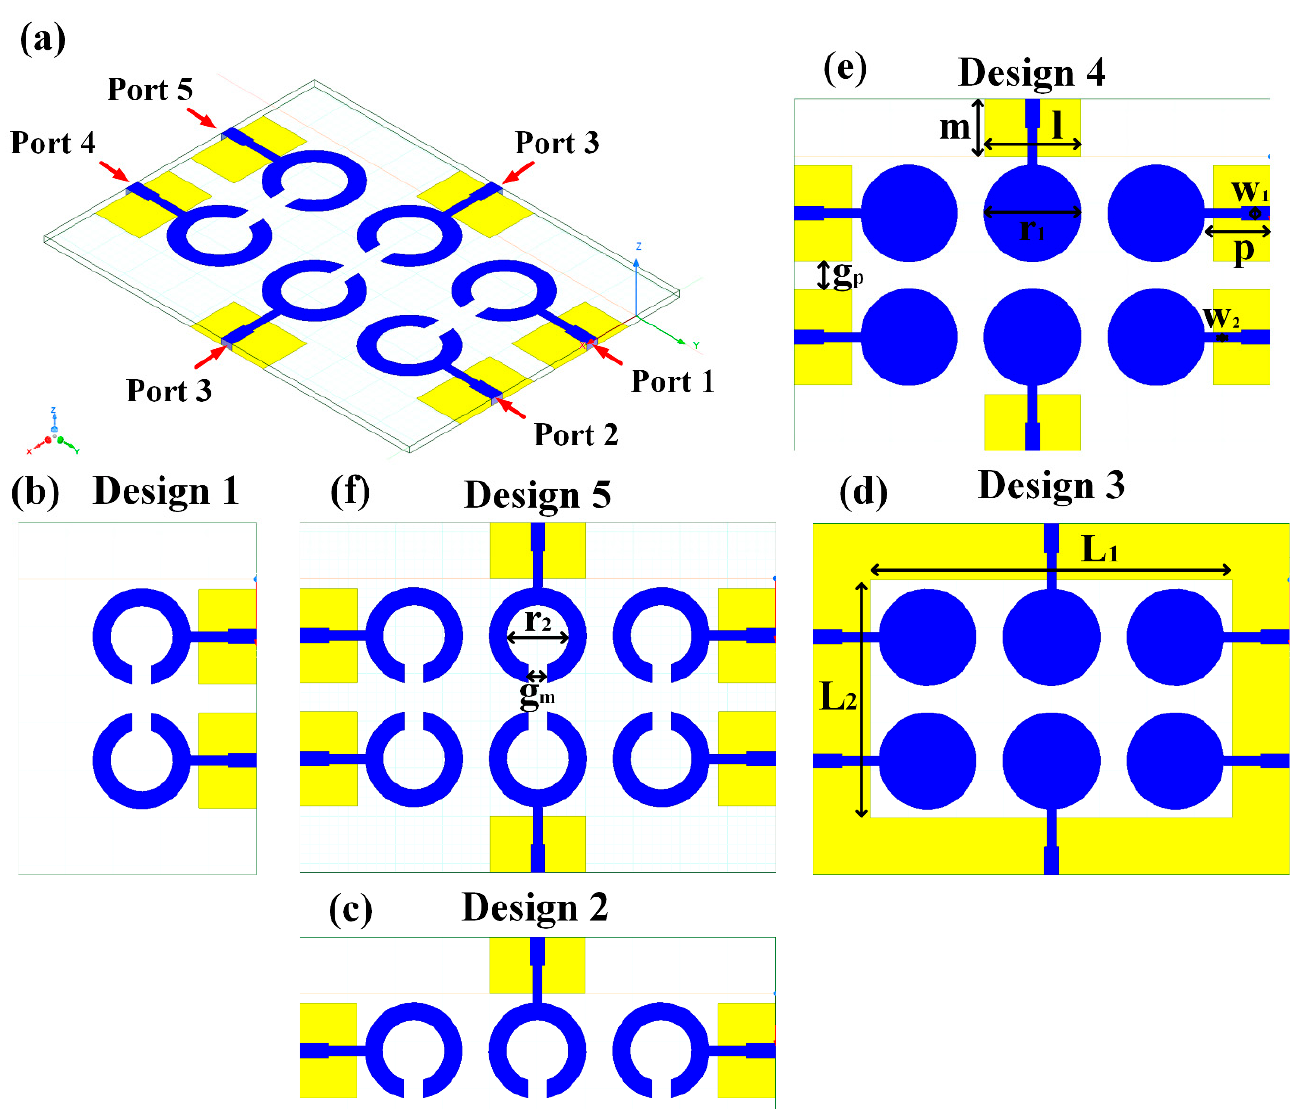
Figure 1. Schematic of the six-element, split-ring resonator-based MIMO antenna with different antenna designs. ( a ) Three-dimensional view of the proposed MIMO antenna with the notation of the input ports. The top and bottom layers of the antenna of copper are formed on the dual-layer FR4 substrate material. Schematic view of ( b )Tow element split ring patch antenna with the rectangular patch (Design 1), ( c ) Three element split ring patch antenna (Design 2), ( d ) Circular patch shaped six element antennas with the continuous ground (Design 3), ( e ) Circular patch shaped six element antennas with a rectangular patch (Design 4), and ( f ) split ring resonator shaped six element anten- nas with rectangular patch. Table 1. Antenna dimensions for the proposed structure of MIMO.